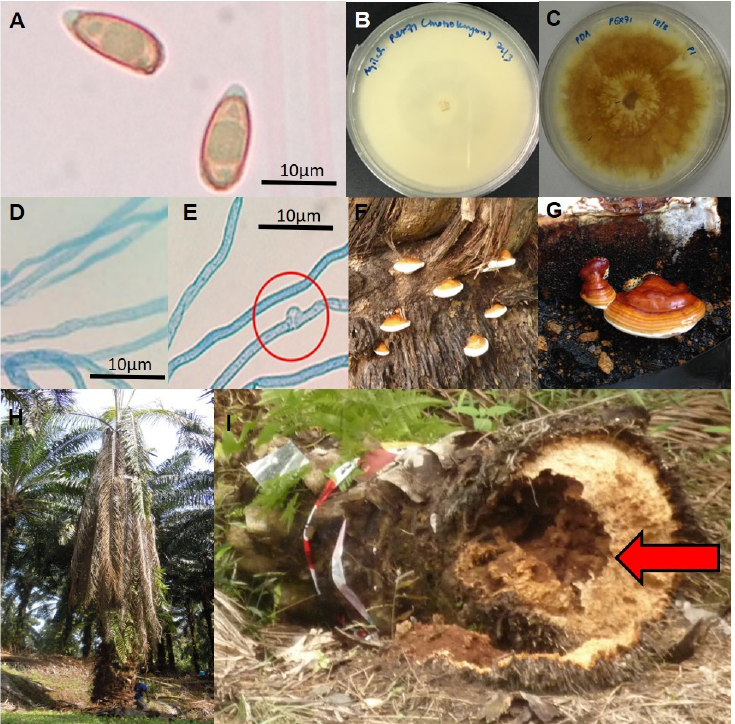
Figure 1. The morphological diversity of G. boninense observed during different life stages. ( A ) Ba- sidiospore structure observed under the light microscope (100X magnification); ( B ) Monokaryotic mycelia of G. boninense PER71 grown on Potato Dextrose Agar (PDA) (age 7 days); ( C ) Dikaryotic mycelia of G. boninense PER71 grown on PDA (age 7 days); ( D ) Monokaryotic mycelia observed under the light microscope (100X magnification); ( E ) Dikaryotic mycelia observed under the light microscope (100X magnification) with the presence of a clamp connection in dikaryotic mycelia (red circle); ( F ) Formation of basidiocarps on the basal stem of the infected oil palm tree; ( G ) Formation of basidiocarps on rubber wood block (artificial inoculation and formation of G. boninense basidiocarps); ( H ) The symptoms of BSR disease observed on oil palm trees, such as lower leaves collapsing and hanging downwards vertically from the point of attachment to the trunk; ( I ) The oil palm trunk falls over due to the decay of the inside basal stem (red arrow). Scale bars: 10 µ m ( A , D , E